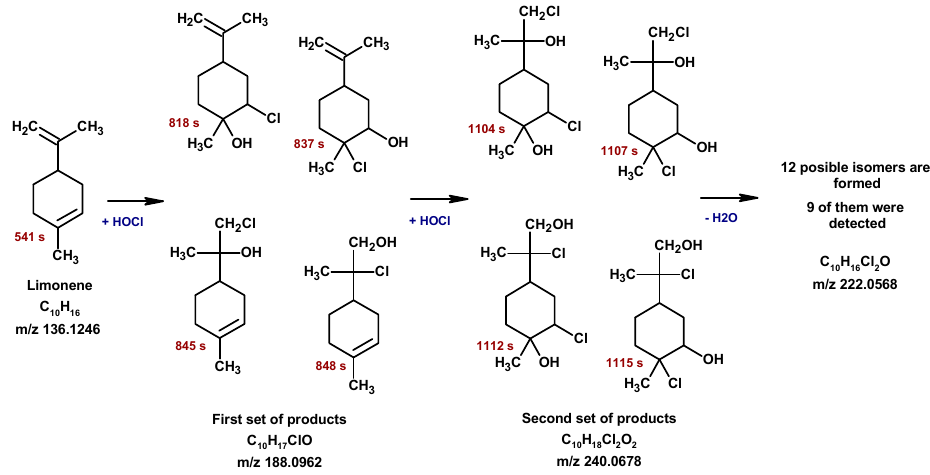
Scheme 1. Main pathways of limonene transformation in conditions of aqueous chlorination with sodium hypochlorite.